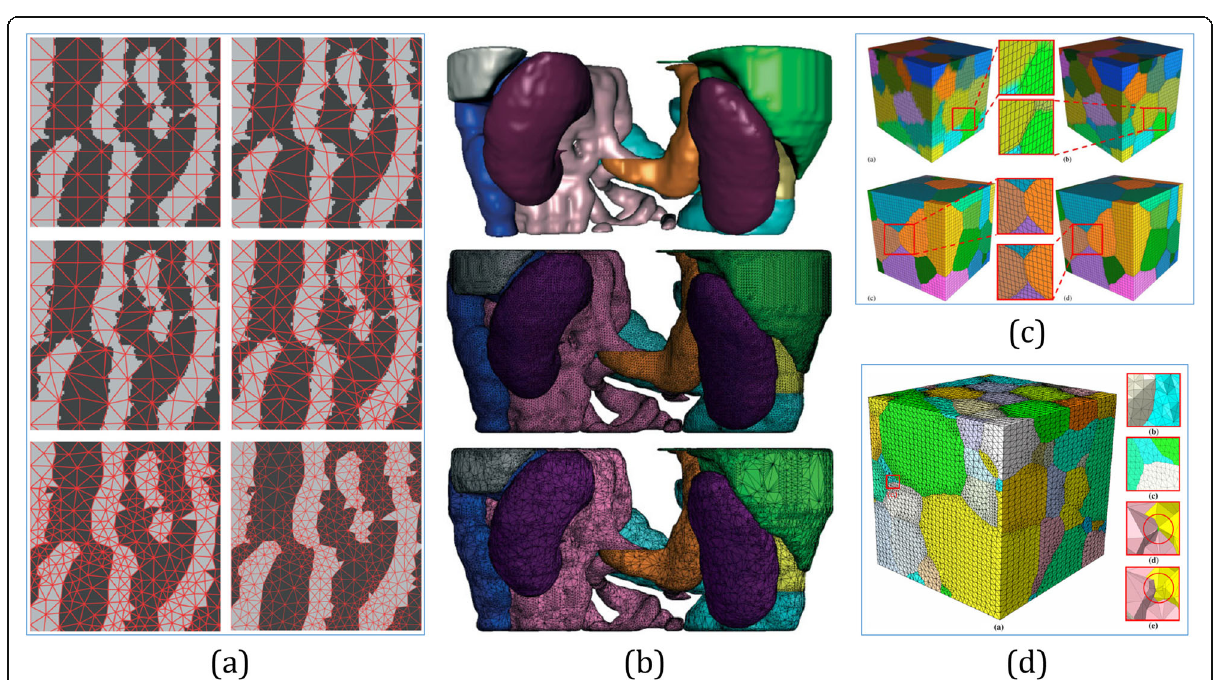
Fig. 5 a Steps in the meshing process of material microstructure employing an image-based FEA [50]. b Surface mesh results before and after decimation using the multiple material marching cubes algorithm [51]. c Non-manifold hexahedral meshes before and after quality improvement for the critical feature determination of microstructure materials [52]. d Adaptive triangular and tetrahedral meshes of a 308-grain polycrystalline material upon resolving topology ambiguity